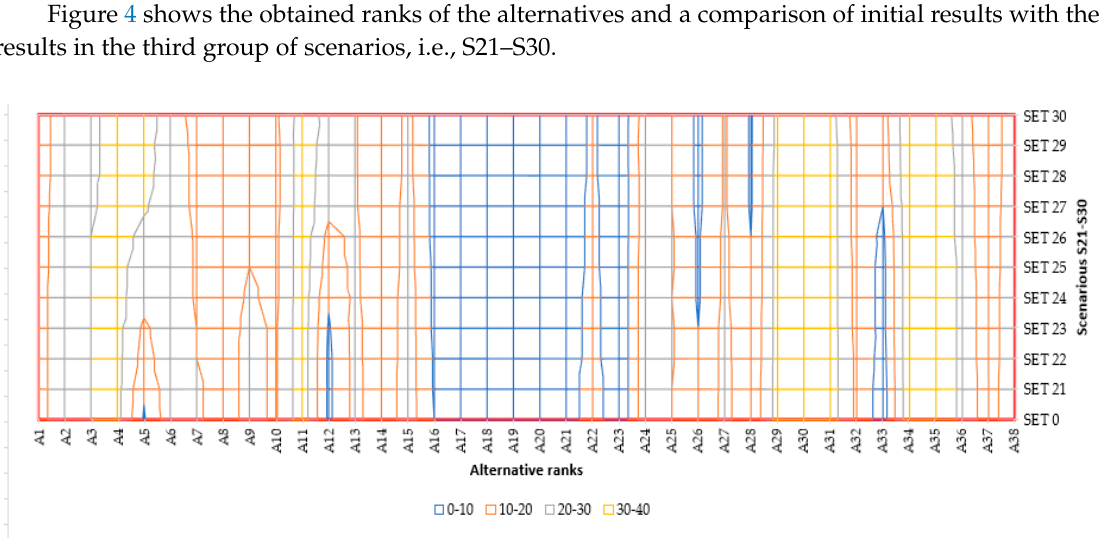
13 of 17 Figure 3. Comparison of initial results with the second group of scenarios, i.e., scenarios S11–S20. The change in the significance of the first criterion affects the ranks of road network sections, which is, in a way, understandable since there is a large number of alternatives. It is important to note that alternatives A23, A18, A20, A12, A5 and A16, which take the first, second, third, eighth, ninth and tenth places, respectively, do not change their positions in any scenario. With the elimination of the significance of the first criterion, since its value is 0.05 in the tenth scenario, there is a change in ranks by five positions for some alternatives. Figure 3 shows the obtained ranks of the alternatives and comparison of initial results with the